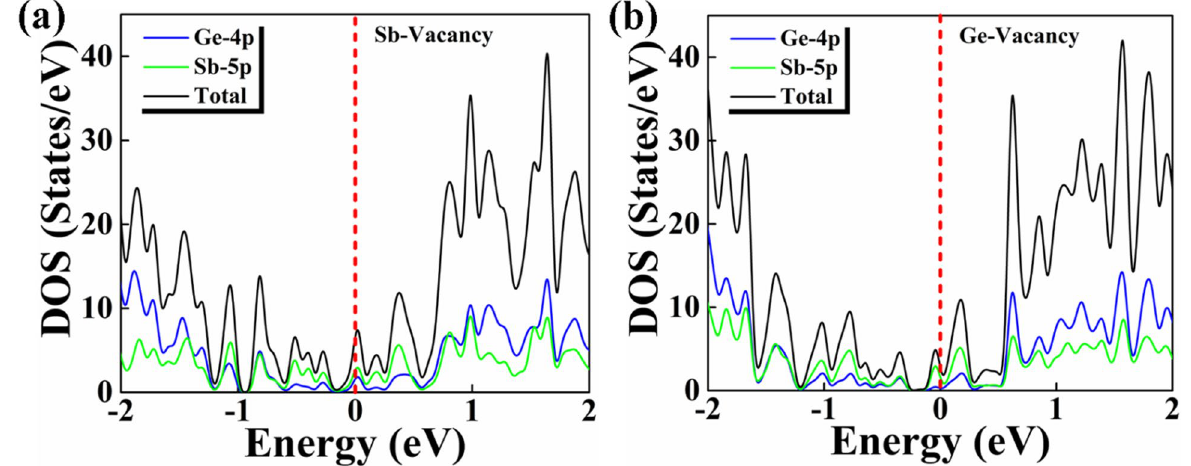
Figure 4. Partial density of states of the Sb/Ge NW with ( a ) the Sb vacancy and ( b ) the Ge